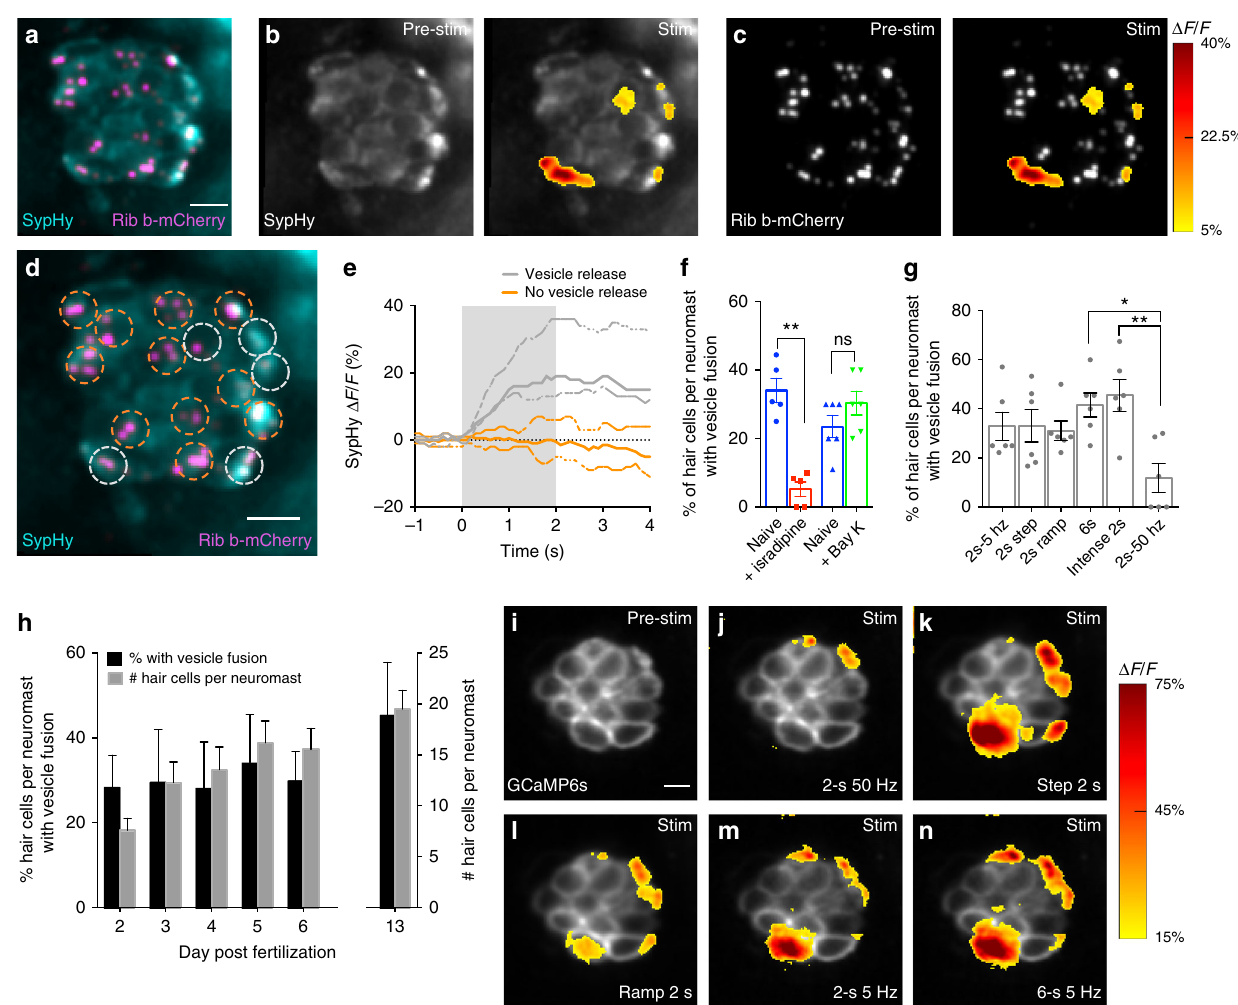
Fig. 2 Presynaptic vesicle fusion occurs in a subset of hair cells. a Neuromast hair cells expressing SypHy (vesicle fusion, cyan) and Ribeye b-mCherry (ribbons, magenta). b , c Spatial patterns of SypHy signals during a 2-s 5 Hz stimulation (right panels) are colorized according to the Δ F / F heat map and superimposed onto a baseline SypHy image ( b , left panel) or onto an image of ribbons ( c , left panel). Only a subset of the hair cells display vesicle fusion. d Dashed circles indicate ROIs (3 µ m diameter) used to detect SypHy signals from example in a – c . e Plot of SypHy signals (mean with upper and lower limits) from cells in d from fi ve cells with (white) and eight cells without (orange) vesicle fusion. f The % of hair cells per neuromast with vesicle fusion (naïve blue, 34.04% ± 3.55, n = 5 neuromasts) decreases after 10 µ M isradipine treatment (red, 5.20% ± 2.16, p = 0.007), but is not altered (naïve blue, 23.50% ± 3.20, n = 6 neuromasts) after 10 µ M Bay K treatment (green, 30.33% ± 3.48, p = 0.10). g The % of hair cells per neuromast with vesicle fusion in response to different stimuli, n = 6 neuromasts per stimulus. h The % of hair cells per neuromast with vesicle fusion does not vary during development despite the increase in hair-cell number, n = 6 neuromasts per age. The % of cells with a SypHy response at day 2 (28.57% ± 3.01) is not different from day 13 (45.47% ± 5.46), p = 0.11. i – n The same subset of hair cells has robust presynaptic Ca 2 + signals in response to a variety of stimuli, n = 5 neuromasts. Similar to g , in j , fewer active cells are observed in response to a 2-s 50 Hz stimulus. A paired t -test was used for comparisons in f . A one-way ANOVA, df = 30 or 2-way ANOVA, df = 25, with post-hoc Tukey ’ s test to correct for multiple comparisons were used in g and h , respectively; * p < 0.05, ** p <